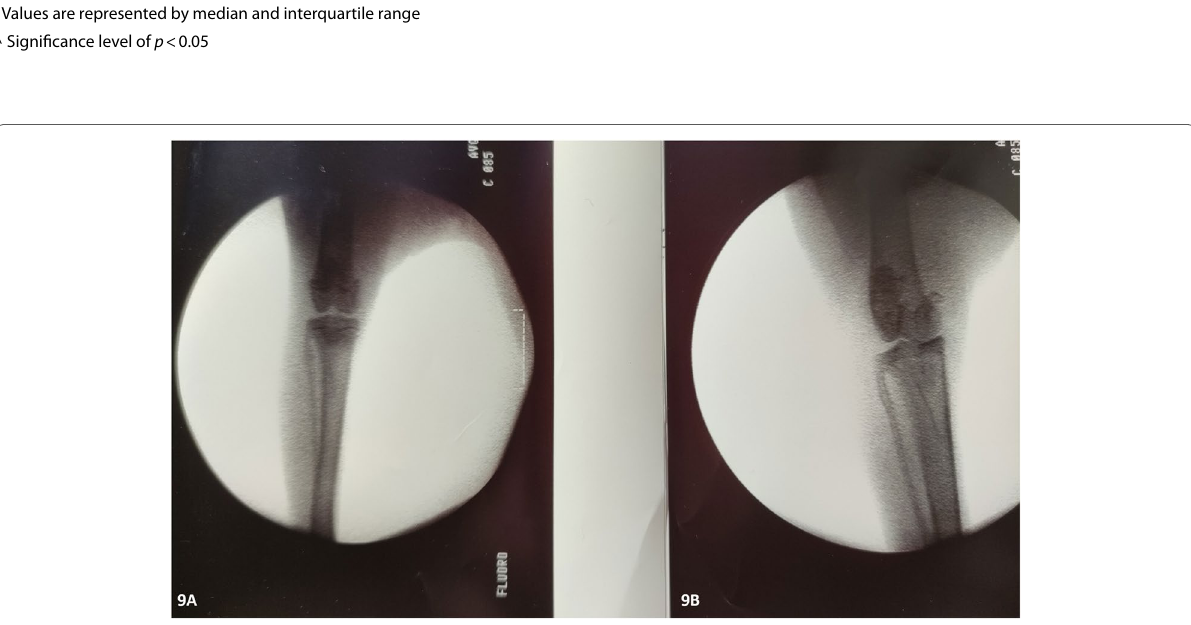
a Values are represented by median and interquartile range ^ Significance level of p < 0.05